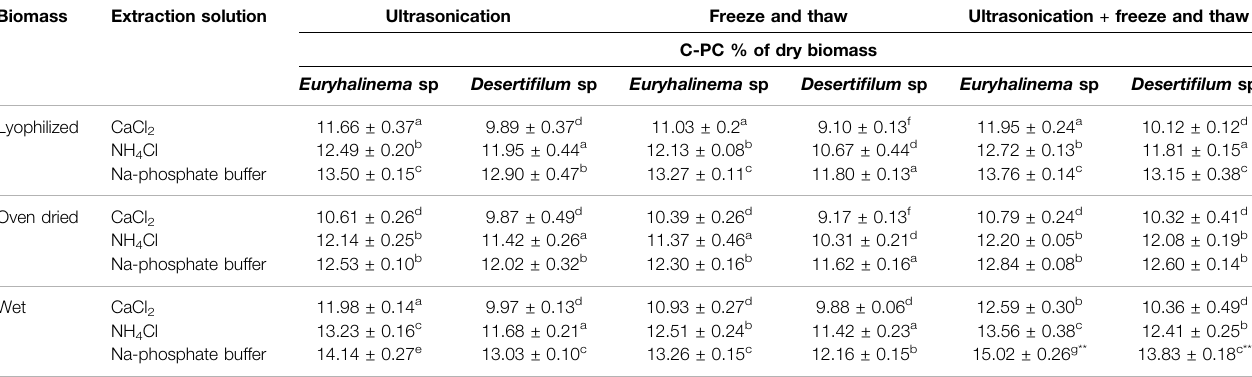
TABLE 1 | Cyanobacterial phycocyanin (C-PC) yield in crude extracts of Euryhalinema sp. and Deserti fi lum sp. obtained by different cell disruption methods and buffers (mean ± SD of the three replications). Biomass